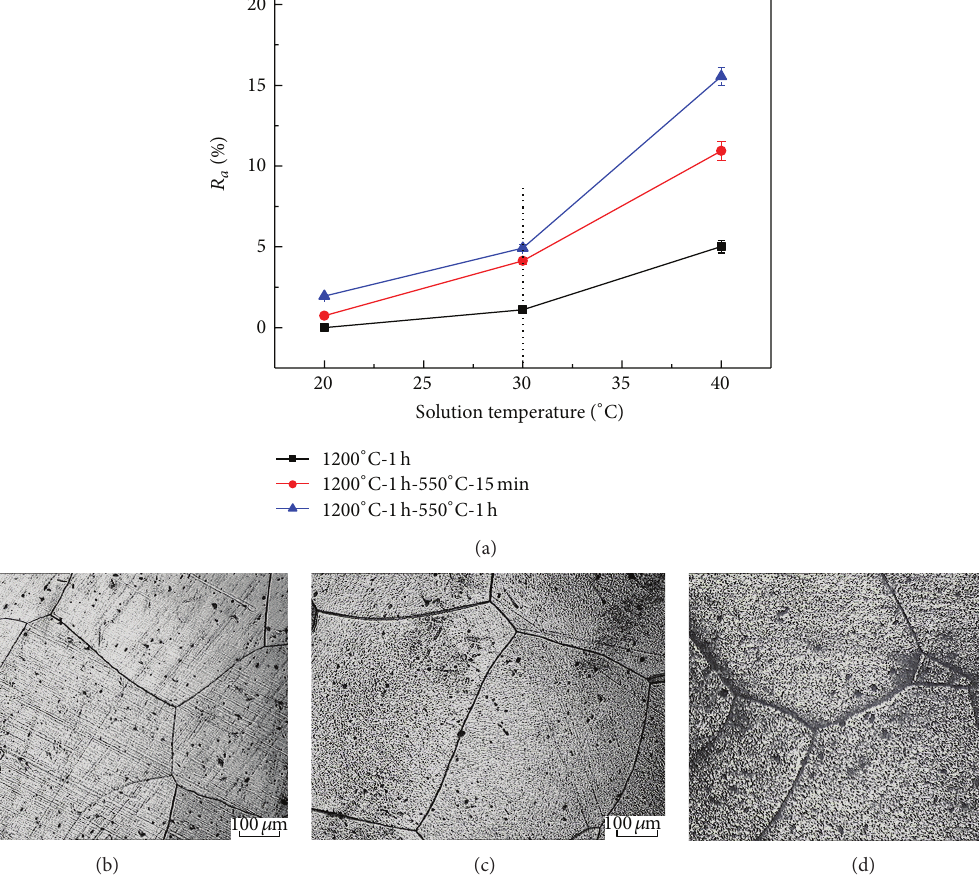
Figure 3: Effect of solution temperature in the DL-EPR test. (a) Influence on 𝑅 𝑎 values (0.5M H 2 SO 4 + 0.0001 M KSCN, 𝑑𝐸/𝑑𝑡 = 100 mV/min); (b)–(d) micrographs of FSS 429 aging at 550 ∘ C for 15min after test, (b) 20 ∘ C, (c) 30 ∘ C, and (d) 40 ∘